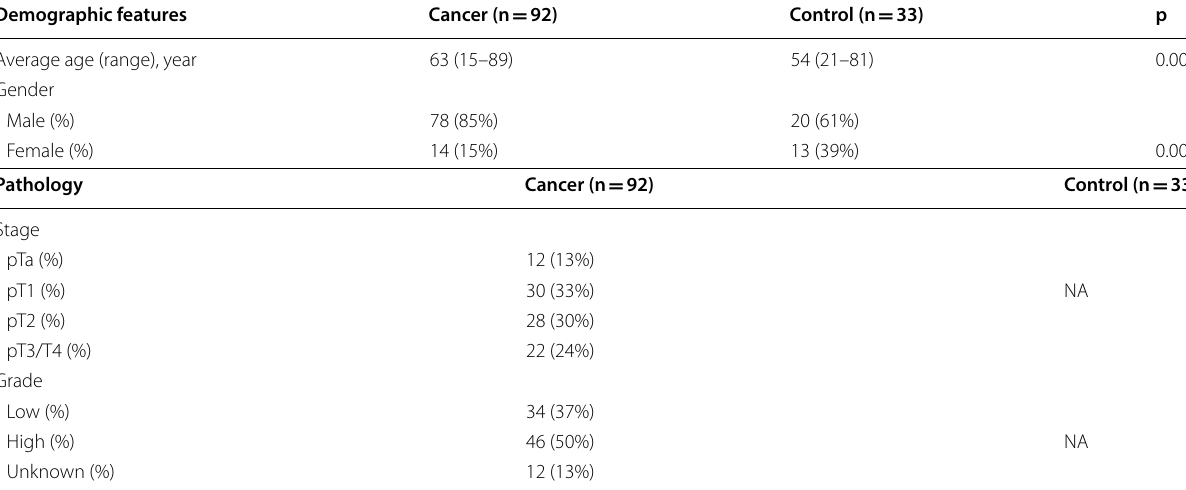
Table 1 Demographic and clinicopathologic features of the study cohorts Demographic